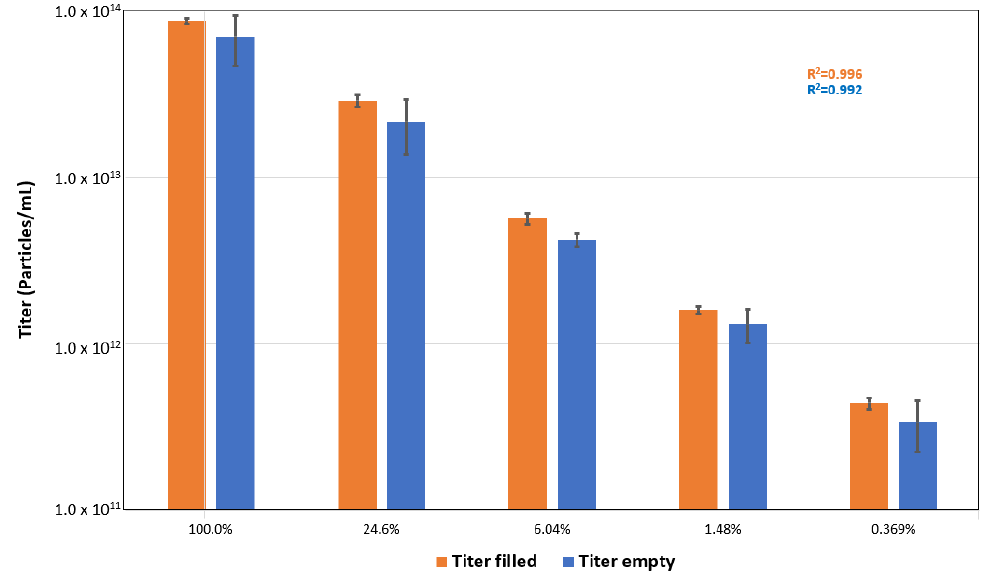
Figure 11. Particle concentrations values obtained for empty and full rAAV5 samples across a range of dilutions expressed in volume-by-volume percentages.